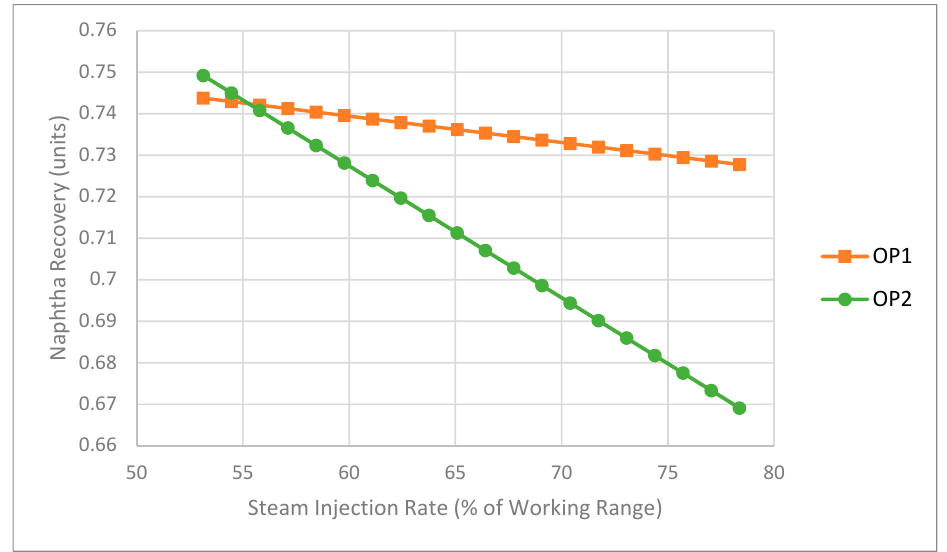
Figure 7. Impact of steam injection rate on naphtha recovery ( NR ) as predicted by statistical models ( NF = 0.863 wt.%, F feed = 4247